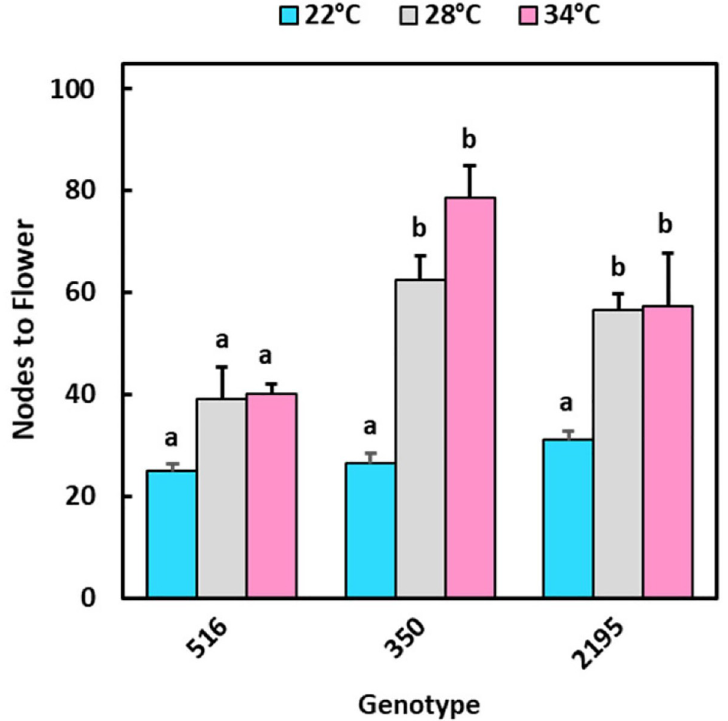
Fig 7. Duration of plant development before flowering in controlled-environment growth chambers at three temperatures treatments (day/night): 22/18˚C (blue), 28/22˚C (gray), and 34/30˚C (red). Number of nodes on main stem to last node before flowering at the apex, or maximum countable nodes in cases where no flowering occurred within the period of observation (200 d). Temperature treatments within each genotype with different lowercase letters are significantly (p � 0.05) different using Tukey’s HSD test. Comparisons and letter assignments were based on estimated marginal means (EMMs, least-squares means), as appropriate for statistical comparisons; arithmetic means and SEMs are